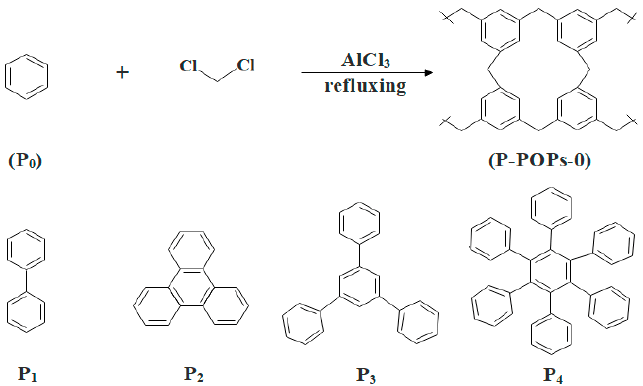
represent the structural formulae of biphenyl, triphenylene, triphenylbenzene and hexaphenylbenzene,